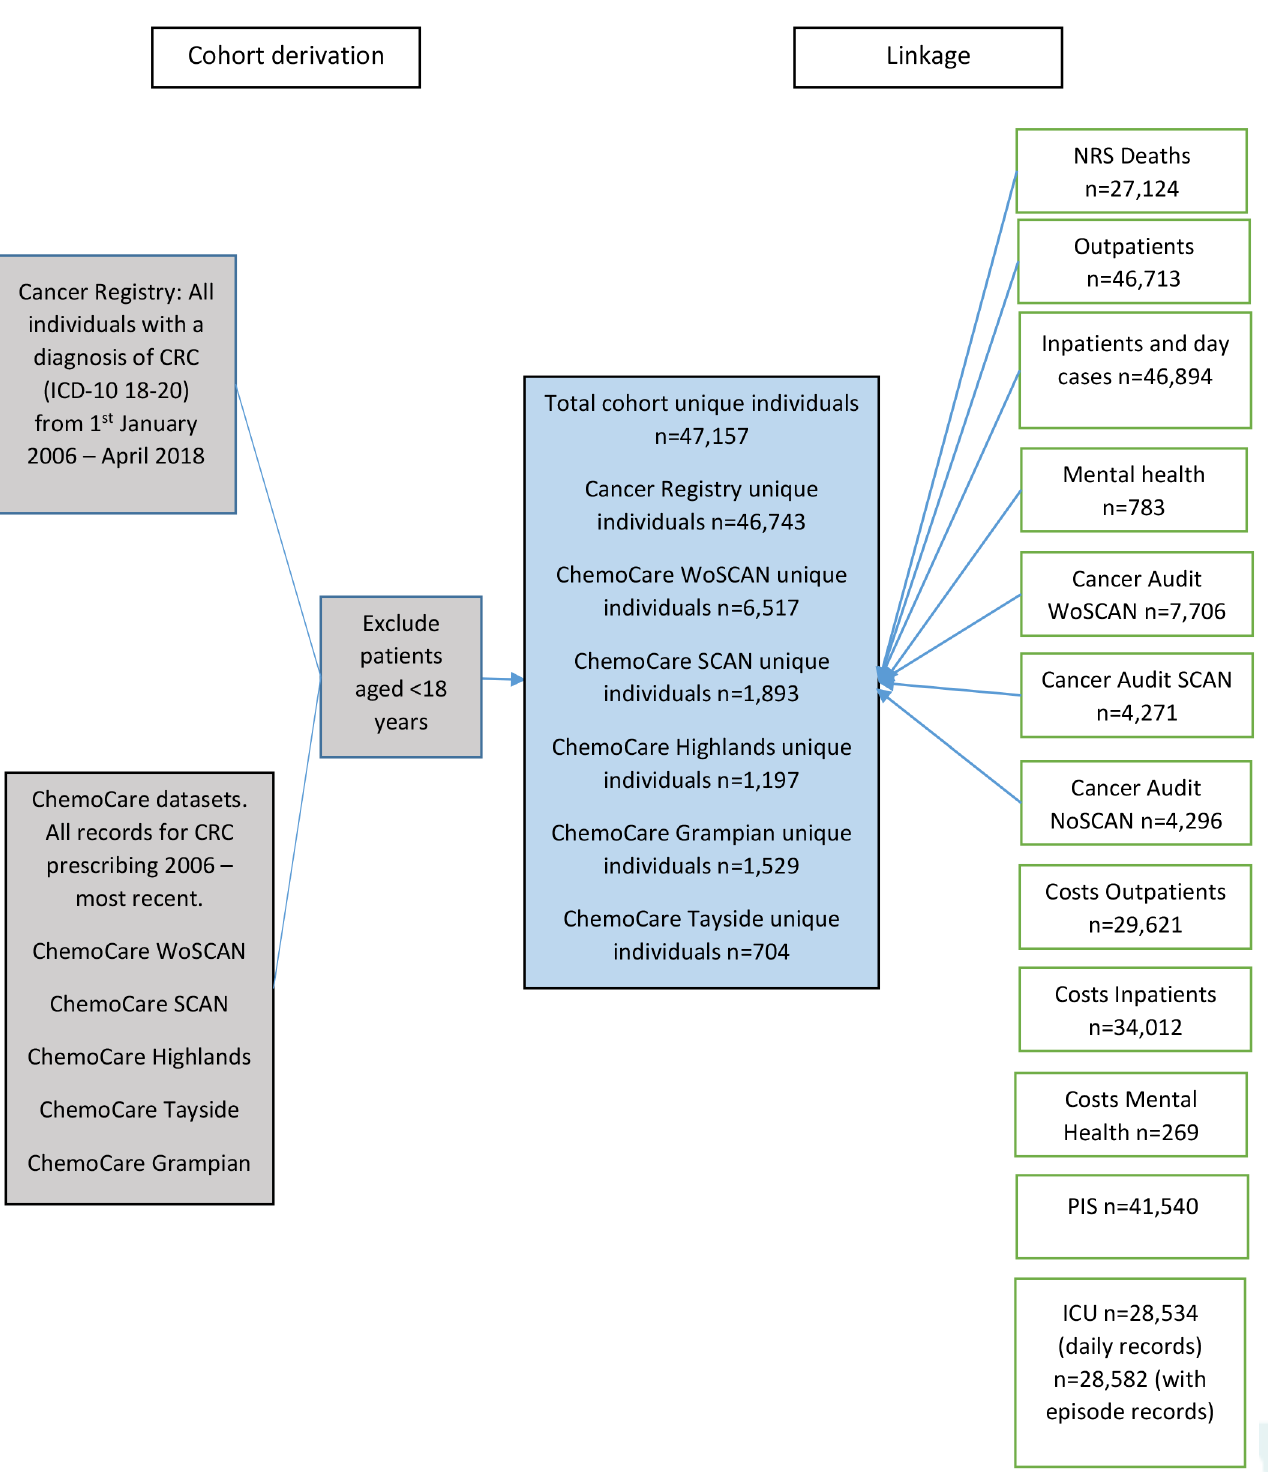
Figure 3: Datasets included in release one and two with the number of patients contained in each dataset